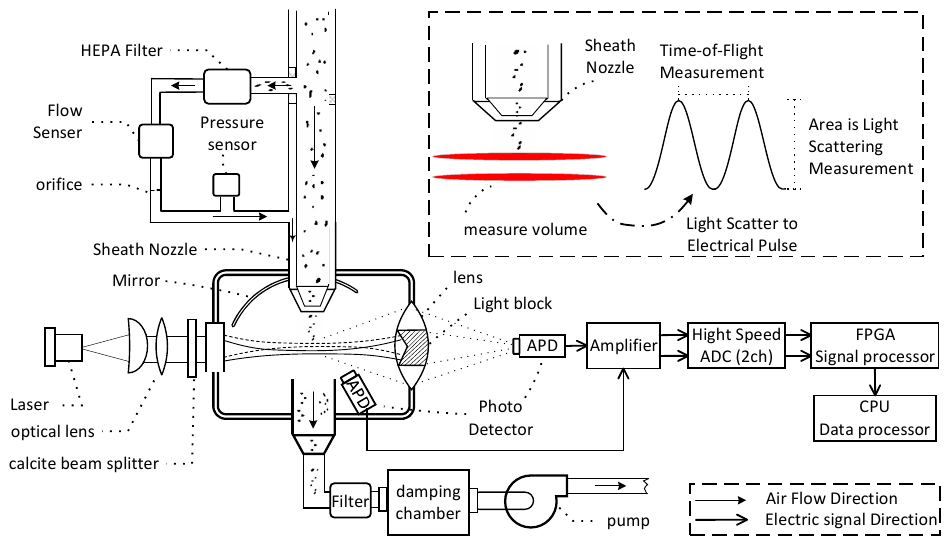
Figure 1. Schematic diagram of the novel instrument. The particle beam, laser beam, and the axis of the mirror are orthogonal to each other.